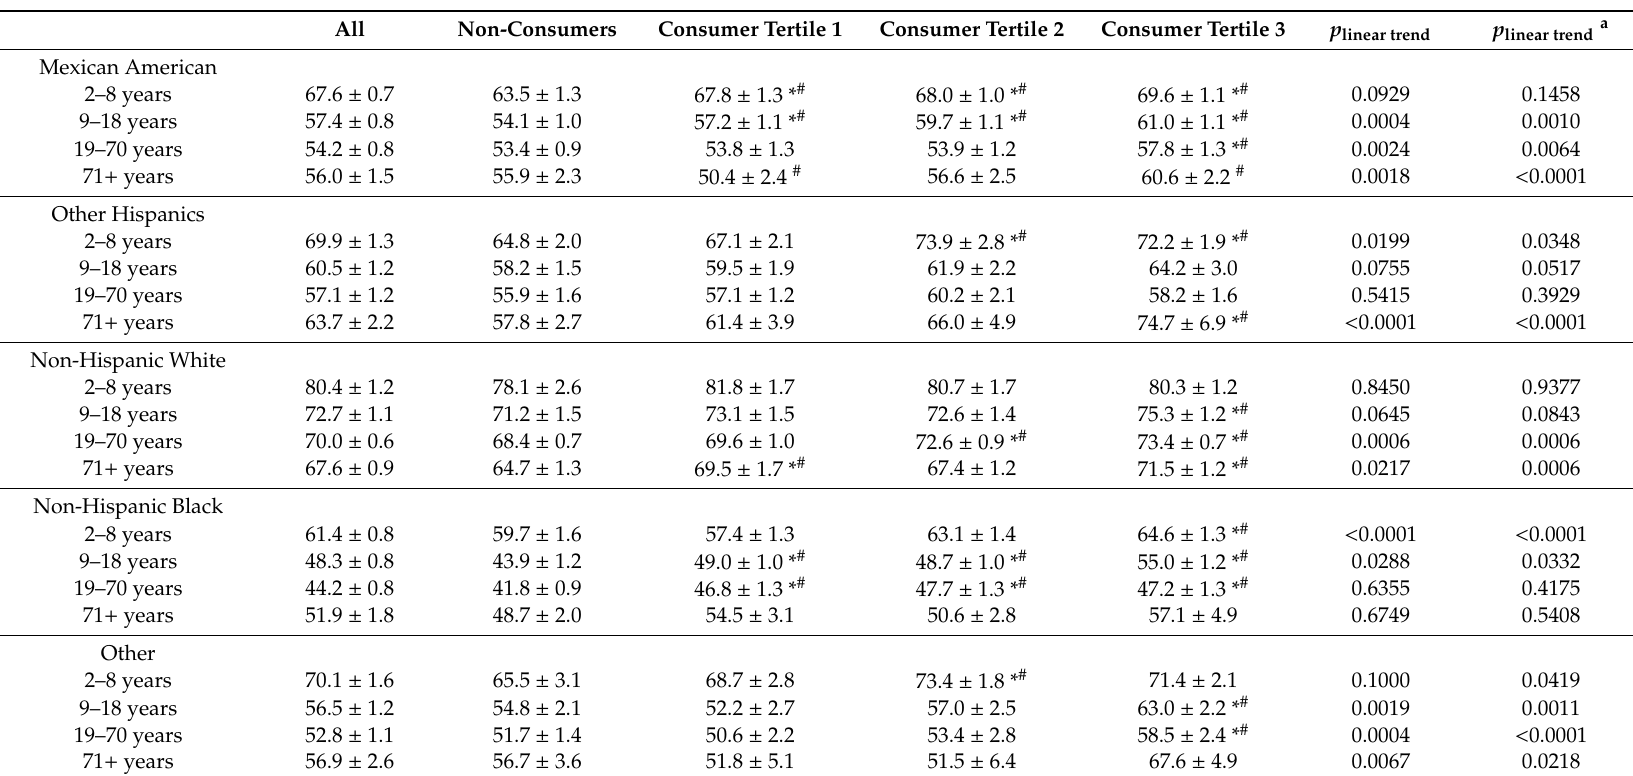
Table 7. Serum vitamin D (serum 25(OH)D) status (nmol / L) by all milk intake in ethnic population groups, NHANES